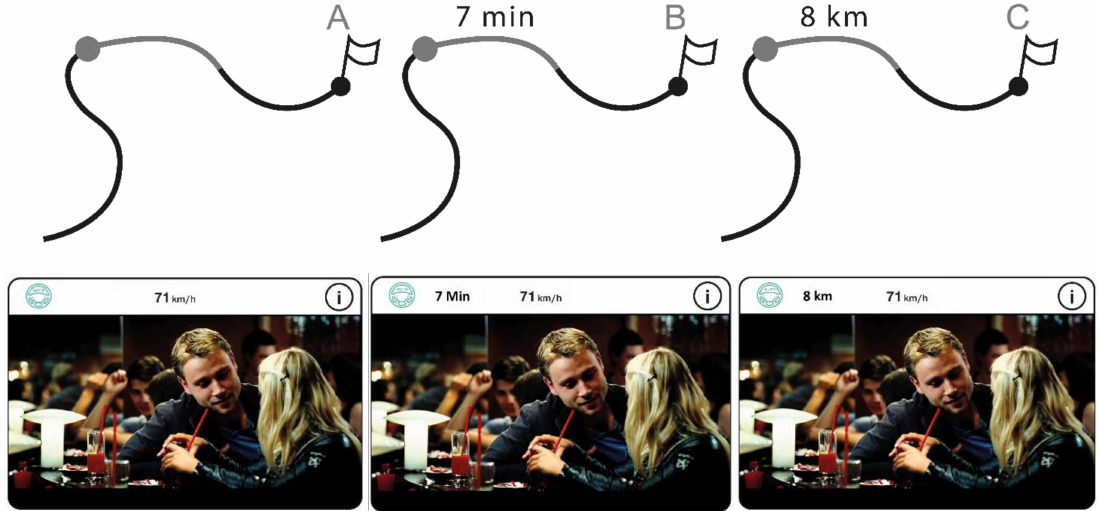
Figure 1. Depiction of navigation map in instrument cluster (IC) ( top ) and central information display (CID) ( bottom ) for the three different human–machine interface (HMI)